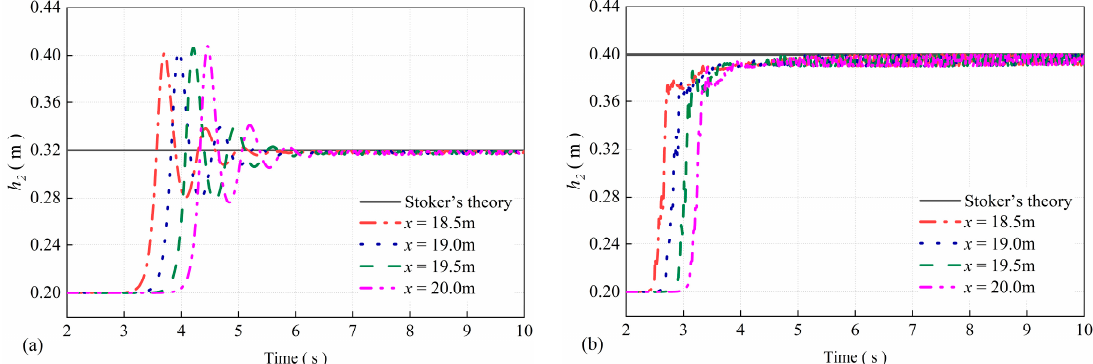
Figure 5. Comparison of the numerical model with Stoker’s theoretical solution for the free surface height: ( a ) h 1 = 0.471 m, h 0 = 0.200 m; ( b ) h 1 = 0.682 m, h 0 = 0.200 m.